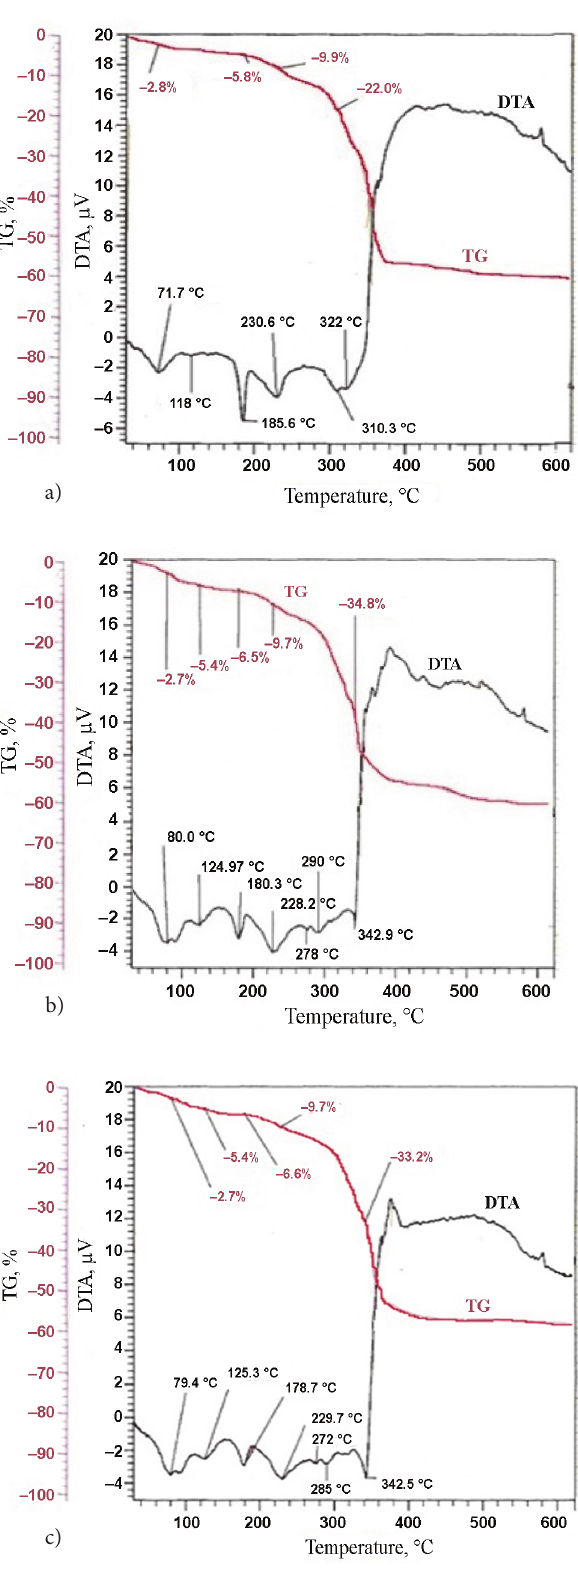
Figure 5. Intumescent fire protective coating THR01 thermograms: a – TG and DTA curves unaged fire coating tested nitrogen; b – TG and DTA curves of fire aged under 60 cycles according to regime I treatment coatings tested nitrogen; c – TG and DTA curves aged 60 cycles according to regime II treatment pursuant to the fire coating tested